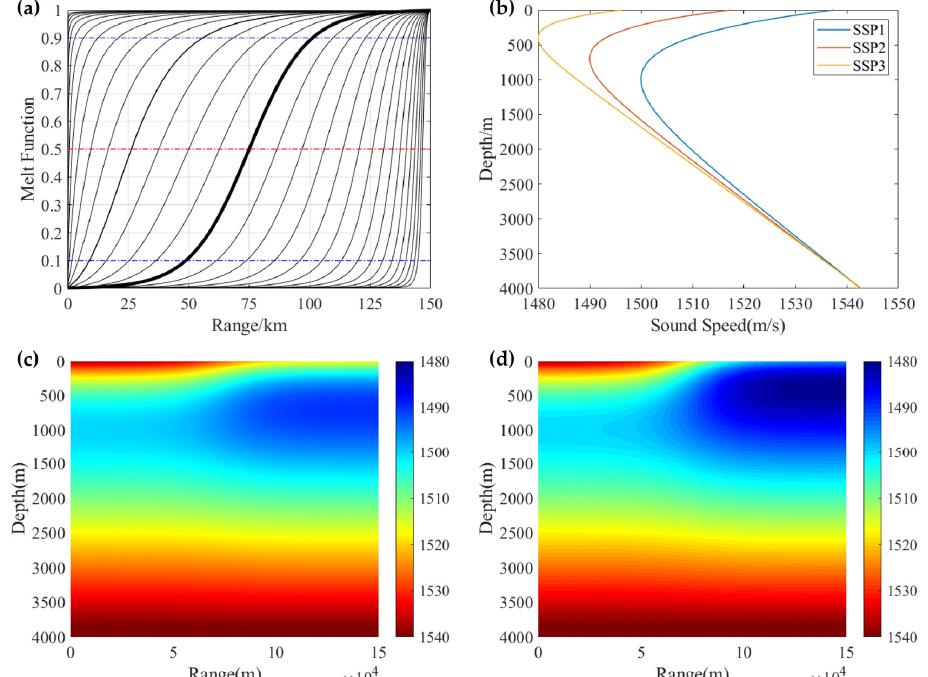
Figure 5. Ocean front model based on SSP [69]: ( a ) the variation of melt function with the range in ocean front model. The blue lines show the melt function at 0.1 and 0.9, respectively, while the red line represents the melt function at 0.5; ( b ) three typical sound speed profiles as input of ocean front model; and ( c , d ) the distribution of sound speed field of ocean front with different intensity output from the model.